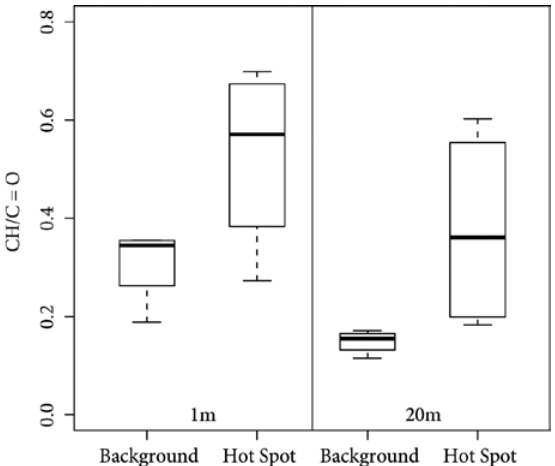
Fig. 6. Boxplot of the CH/C = O ratios for dark coloured hot spots and neighbouring background of snow meltwater filter sediment sampled at 1 m (left) and 20 m distance (right) from road. n =